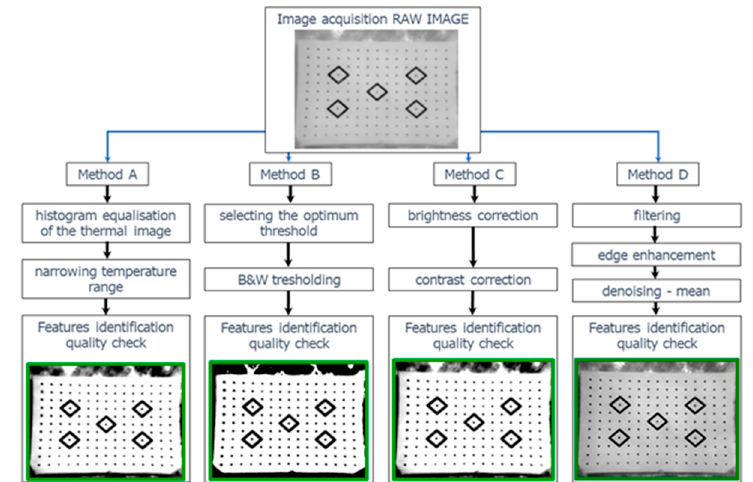
Figure 10. Methods of image processing flow.